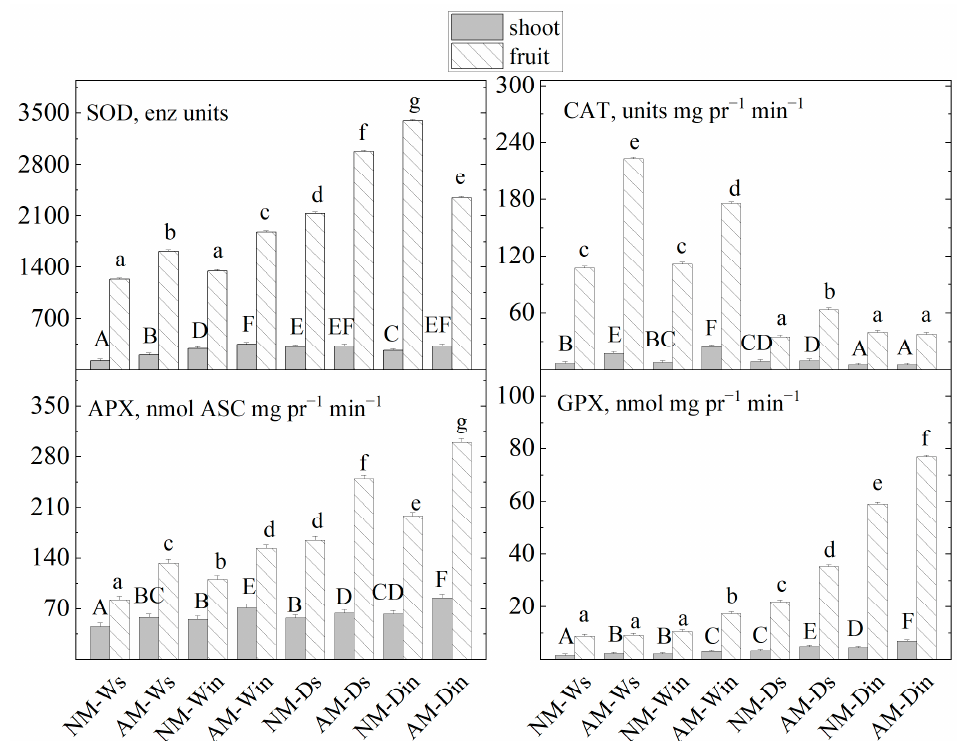
Figure 4. Activities of superoxide dismutase (SOD), catalase (CAT), guaiacol peroxidase (GPX), and ascorbate peroxidase (APX) in P. peruviana (leaves and fruits): non-mycorrhizal ( NM ), AMF-inoculated ( AM ), well-watered ( W ), drought-stressed ( D ), seed-propagated ( s ), and in vitro propagated ( in ) plants. Values are average ± SE, n = 3; common letters indicate no significant differences as determined by Fisher LSD test ( p ≤ 0.05) after performing ANOVA analysis. The statistical analyses of leaves (uppercase) and fruit (lowercase) were performed separately.